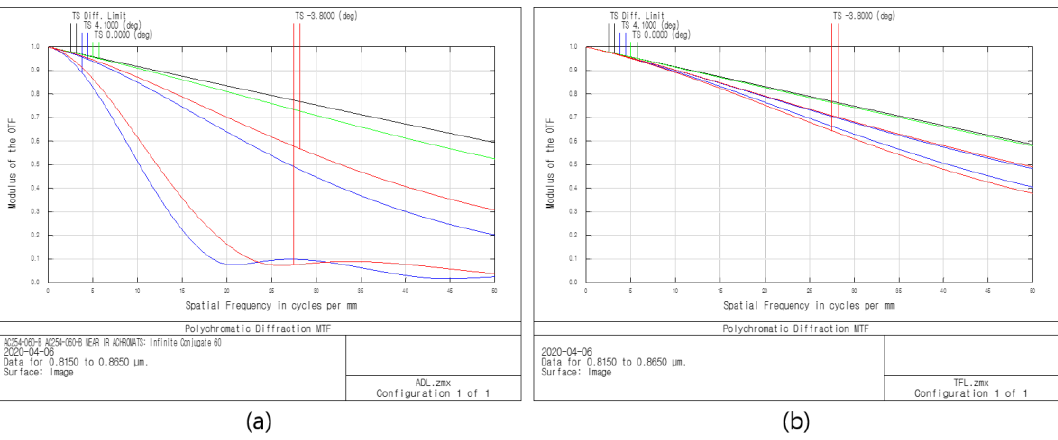
Figure 6. The modulation transfer function (MTF) curve for ( a ) the ADL and ( b ) the TFL at three incident angles of 0 degrees, − 3 degrees, and 4 degrees corresponding to three wavelengths of 815 nm, 840 nm, 865 nm, respectively.